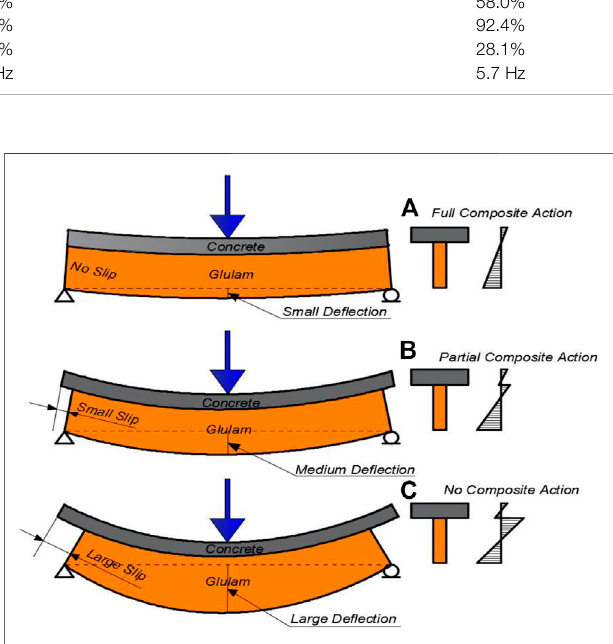
FIGURE 3 | The concept of timber-concrete composite